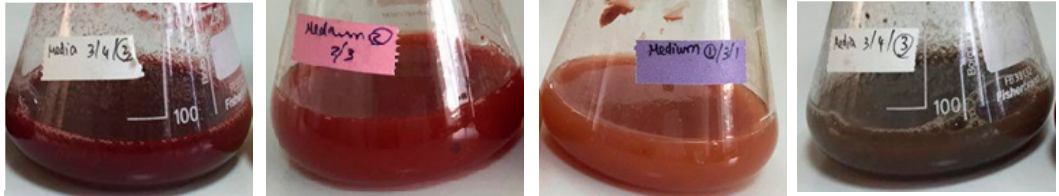
Figure 6. Observation of the different shades of pigments produced in different saline media (from left to right, 0, 3.65, 6, 9%).